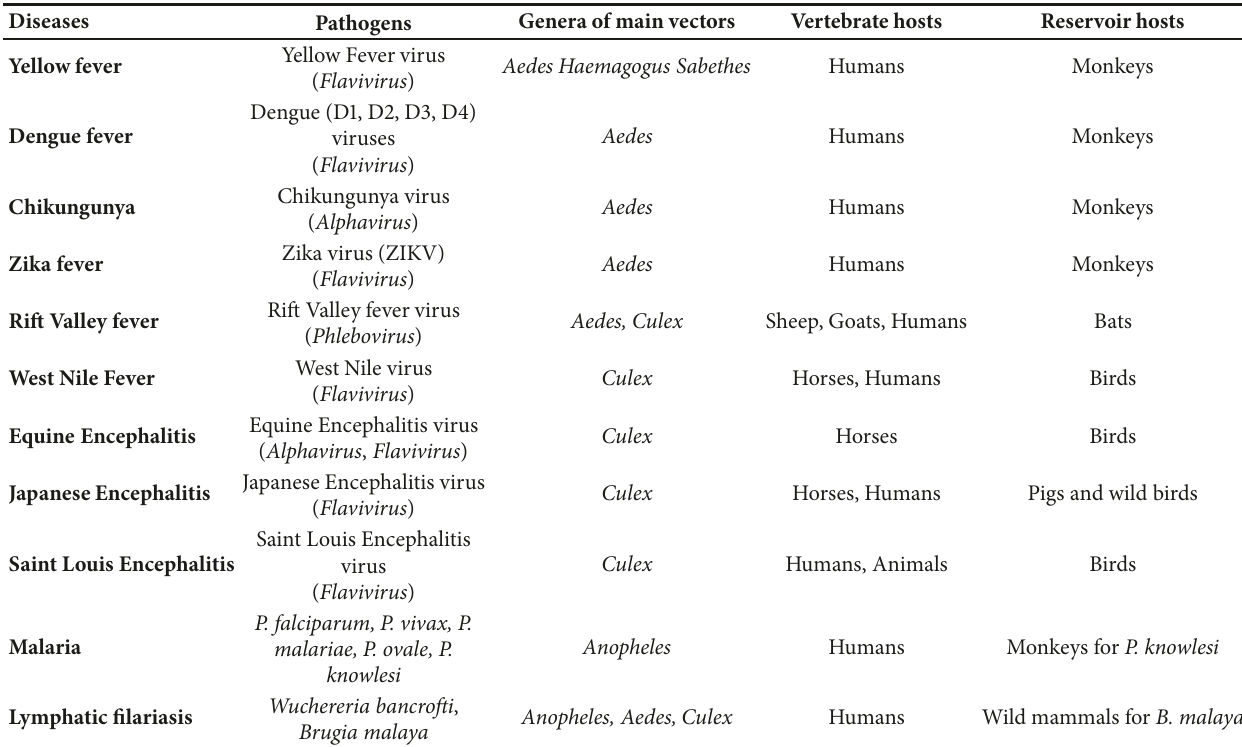
Table 3: Main diseases transmitted by